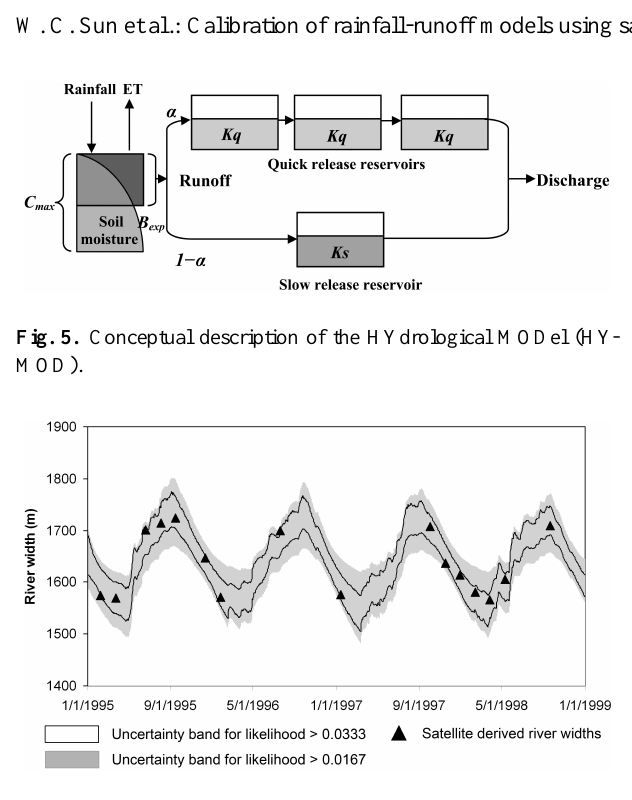
Fig. 6. Uncertainty bands for river width simulations made from parameter sets with associated likelihood values higher than 0.0167 and 0.0333.